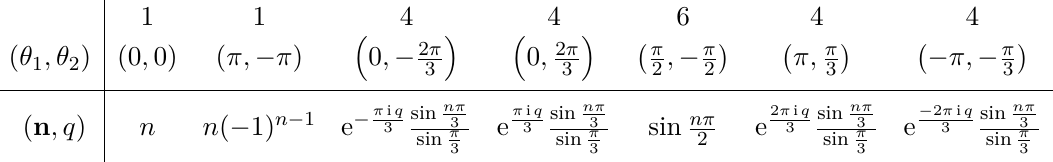
Table 10. Characters for the irreps of U (2) restricted to the subgroup SL(2 , F 3 ) with the subgroup embedding